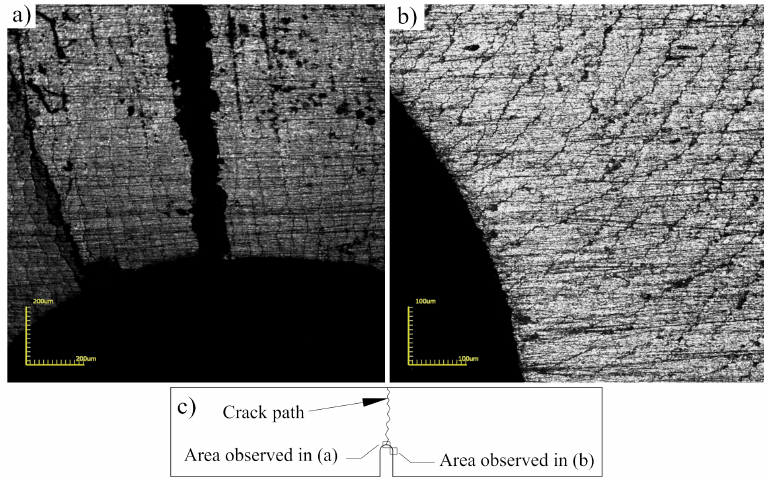
Figure 8. Microcracks in the region around the notch tip of the specimen with the thickness of 7 mm and notch tip radius of 1 mm: (a) notch tip apex, 216×; (b) notch tip sideline, 430×; (c) sketch indicating the observed regions.